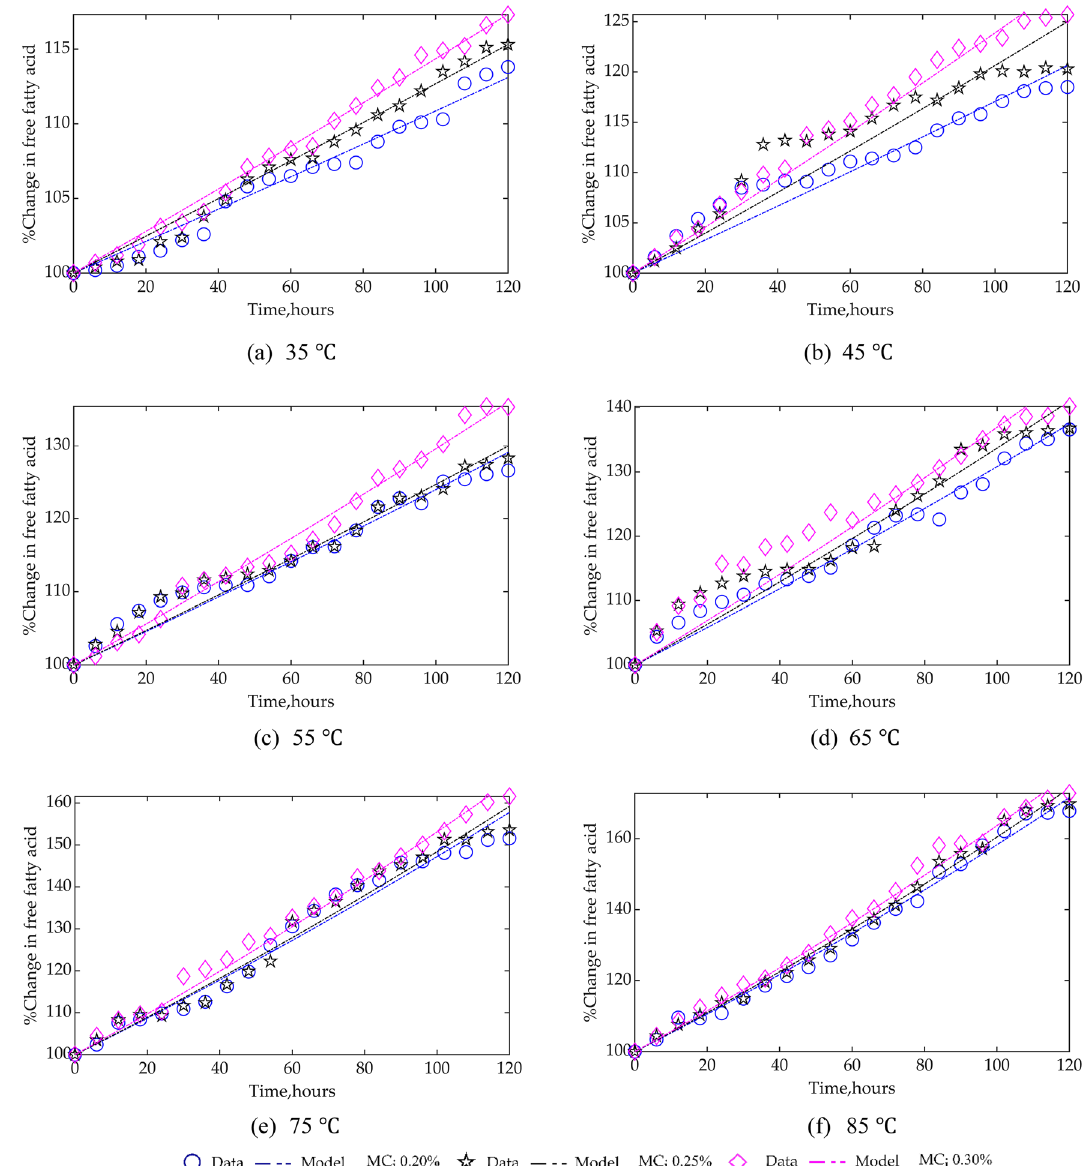
Figure 3. Comparison of experimental data and kinetic model of CPO FFA at different temperatures and MC i .